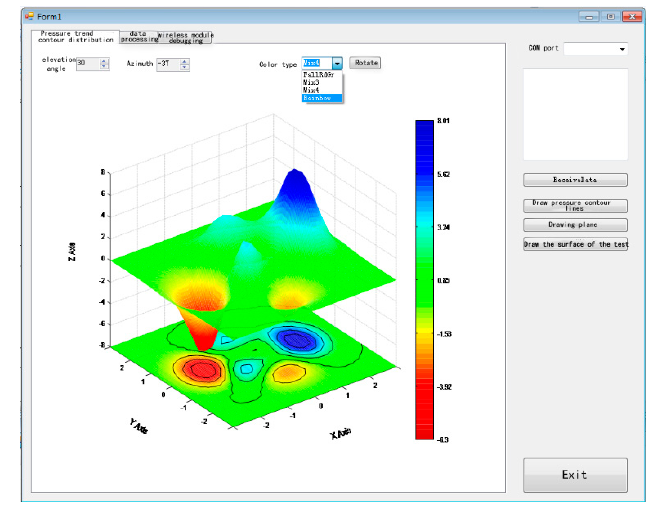
Figure 9. Host computer software interface.